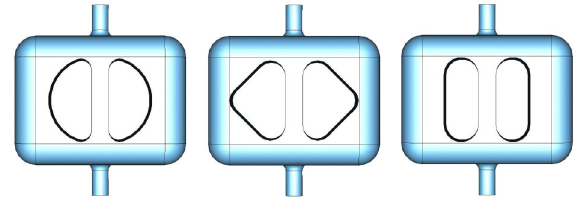
FIG. 11. Product of transverse shunt impedance ( R t ) and sur- face resistance ( R s ) with varying radius of cylindrical-shaped parallel bars [Design (A)].